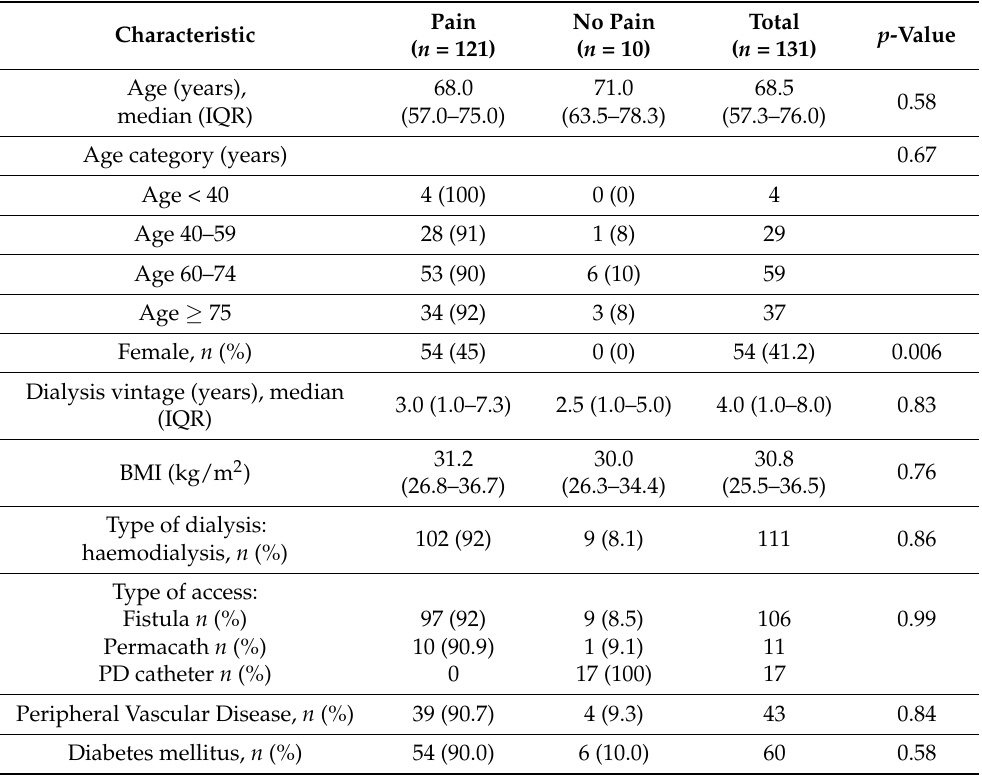
Table 2. Demographic and clinical characteristics of study participants, stratified by patients who experienced pain and patients who did not experience